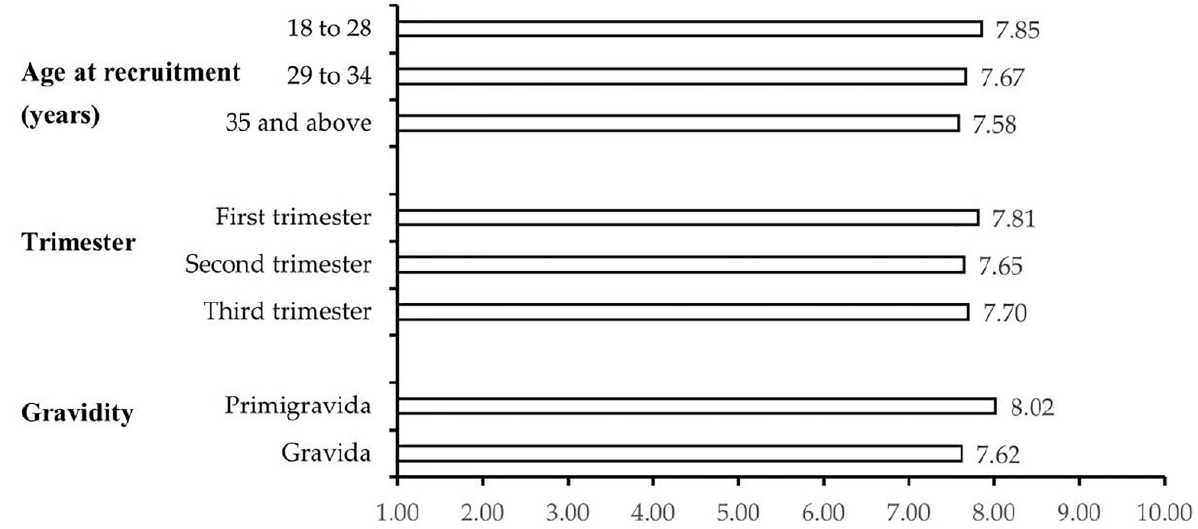
Fig 2. Distribution of median happiness scores by demographic groups amongst pregnant women in Al Ain, UAE. The Mutaba’ah Study.